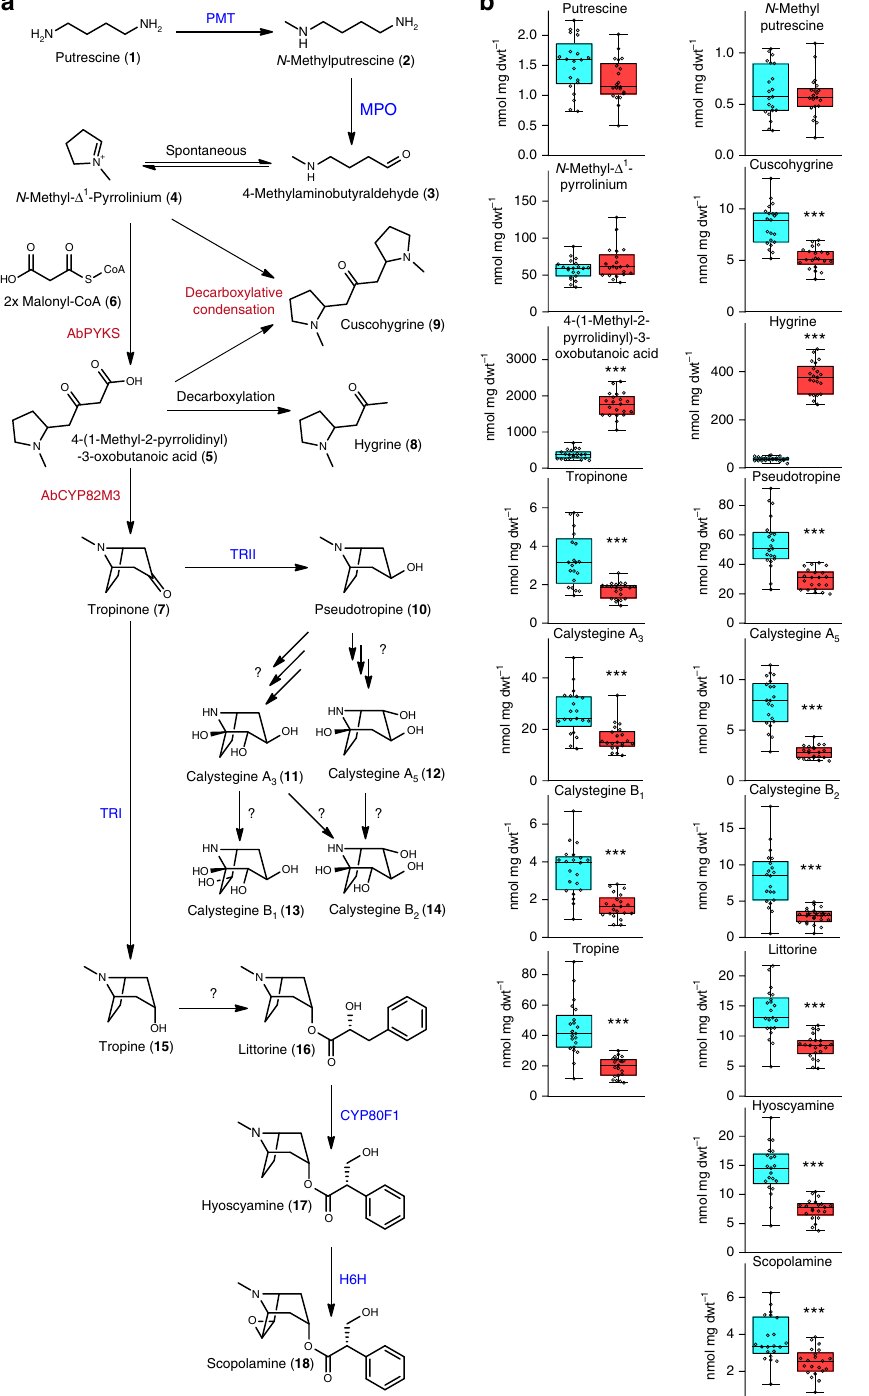
Fig. 5 Silencing of AbCYP82M3 disrupts tropane and pyrrolidine alkaloid biosynthesis. a The tropane and pyrrolidine alkaloid biosynthetic pathway in the Solanaceae starting from putrescine ( 1 ). Experimentally validated enzymes are shown in blue, AbPYKS and AbCYP82M3 are shown in red, and unknown reactions are noted with question marks. Enzyme abbreviations are as follows: PMT putrescine methyltransferase, MPO methylputrescine oxidase, TRI tropinone reductase I, TRII tropinone reductase II, CYP80F1 littorine mutase, H6H hyoscyamine-6-hydroxylase. Formation of cuscohygrine ( 9 ) via nonenzymatic decarboxylative condensation as per Supplementary Figure 5 is shown in red. b Abundance of tropane and pyrrolidine alkaloids together with selected precursors in TRV2 empty vector control lines (cyan bars) and AbCYP82M3 VIGS lines (red bars). Data are presented as the mean n = 21 biological replicates. Asterisks denote signi fi cant differences (*** p < 0.001) as determined by Student ’ s t test. For each box plot, the lower and upper bounds of the box indicate the fi rst and third quartiles, the line indicates the median value, and the whiskers extend to the minimum and maximum